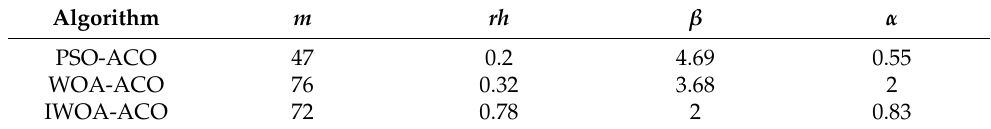
Figure 12. The convergence curve of the evaluation function in the simulation of bump environment. Table 4. The parameter values of ACO in the simulation of bump